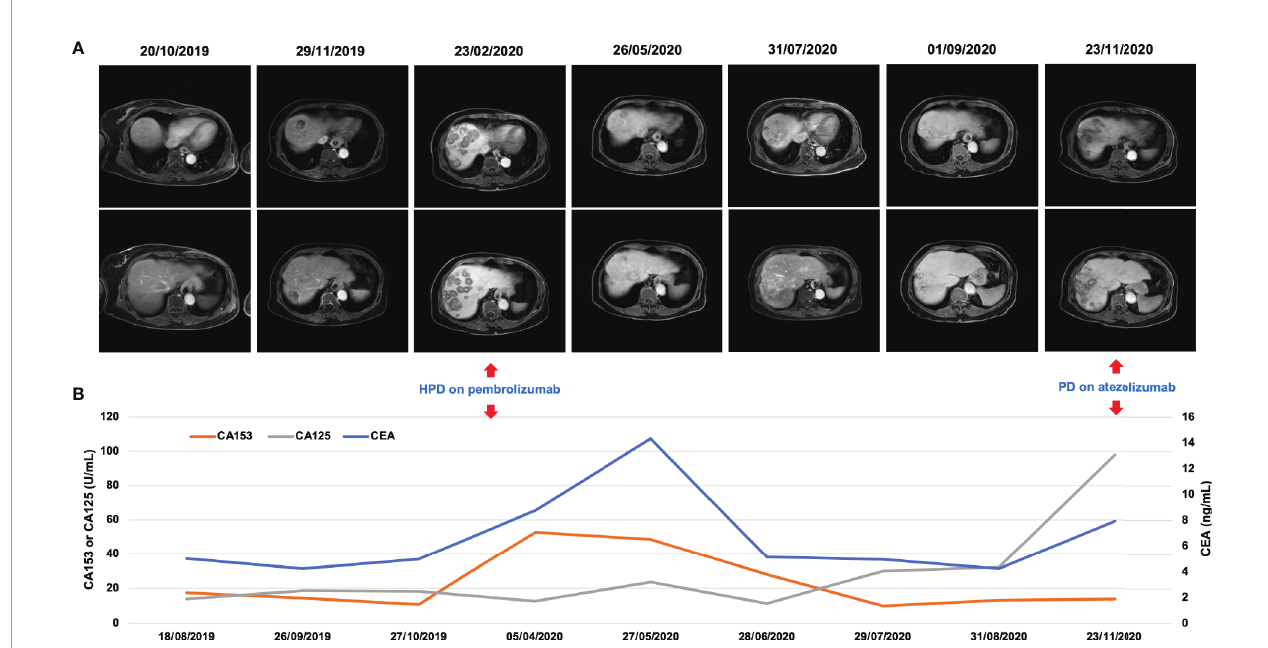
FIGURE 3 | Radiological evaluation and altered levels of circulating tumor markers before and after HPD. (A) After receiving immunotherapy with pembrolizumab, this patient developed HPD. An MRI scan showing more extensive and large metastatic lesions in the liver, which responded well to rechallenge with atezolizumab in May 2020, and necrotic areas. (B) Dynamics of the levels of circulating tumor markers (CEA, CA125, and CA153) before and after